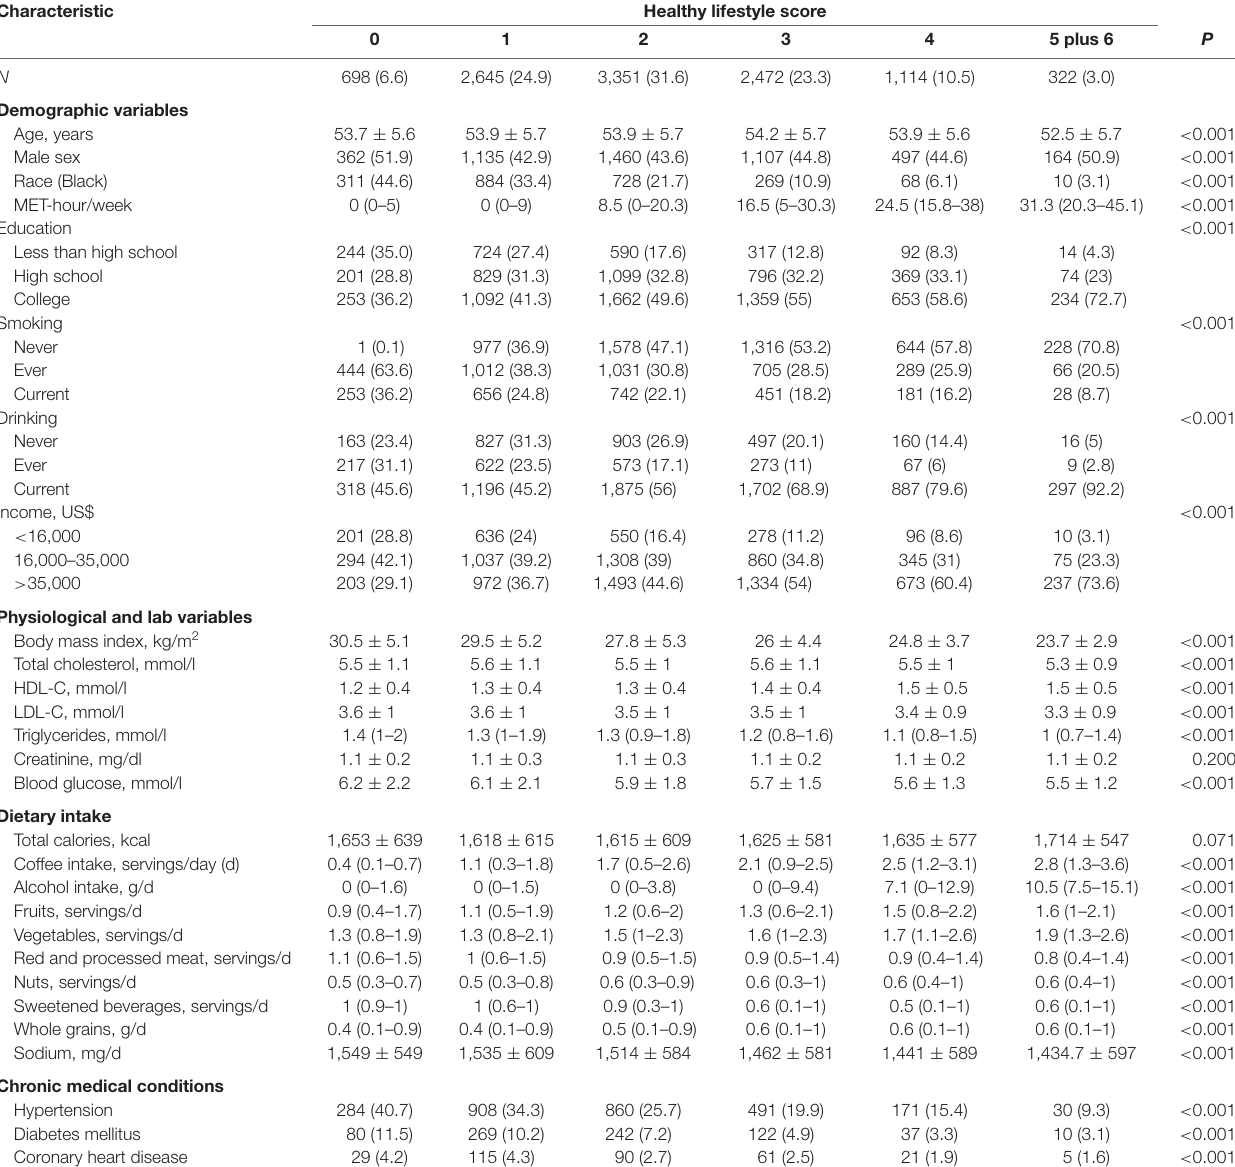
TABLE 1 | Baseline (1987–1989) participant characteristics grouped by healthy lifestyle